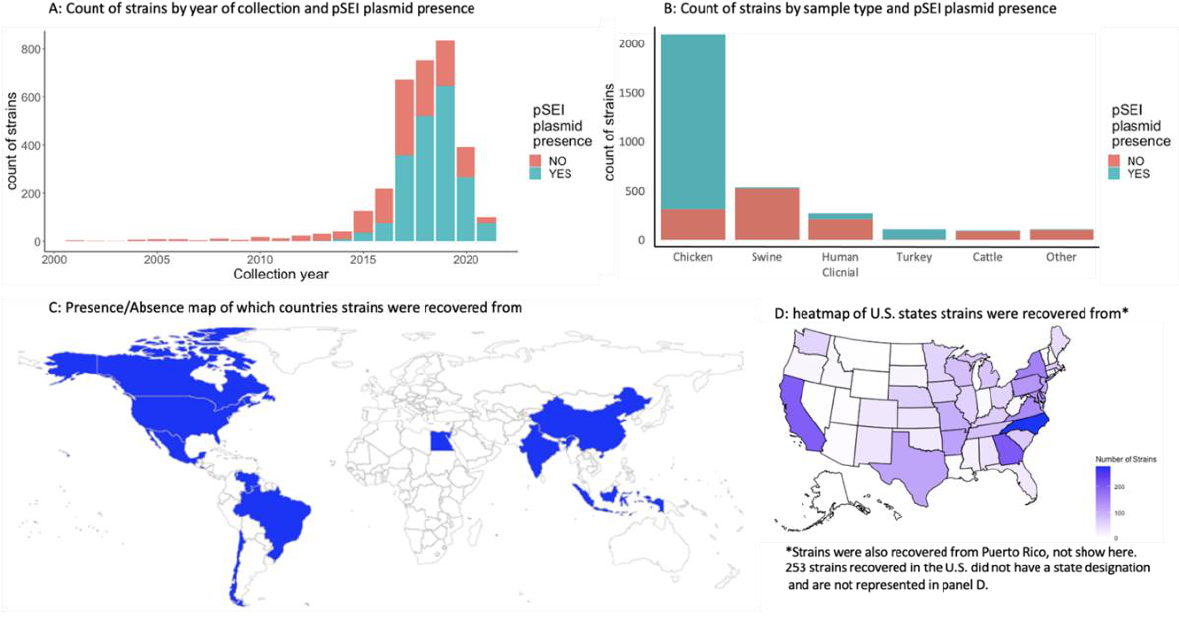
Figure 2. Metadata summary of Salmonella Infantis strains included in the study by ( A ) year of collection, ( B ) environment of isolation, and ( C , D ) geographical location of collection.